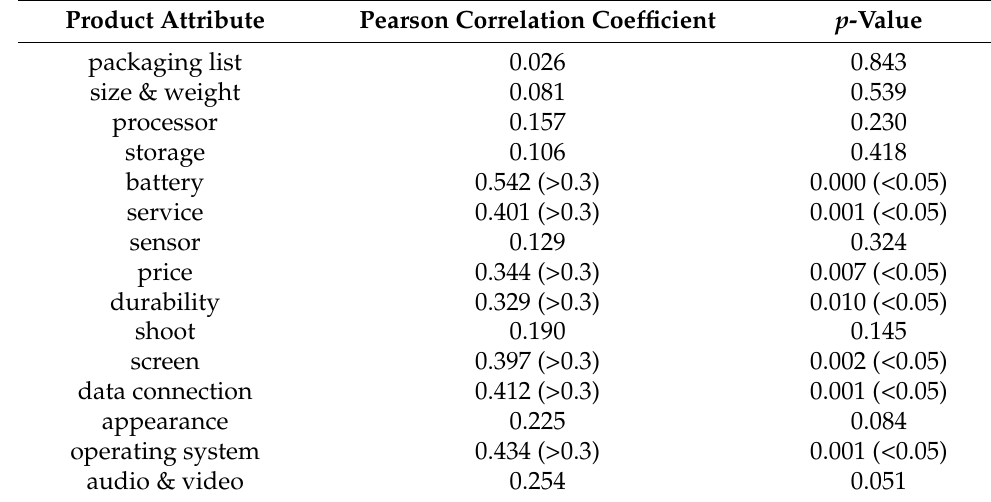
Table 3. Pearson correlation coefficient for P and bad review rate.